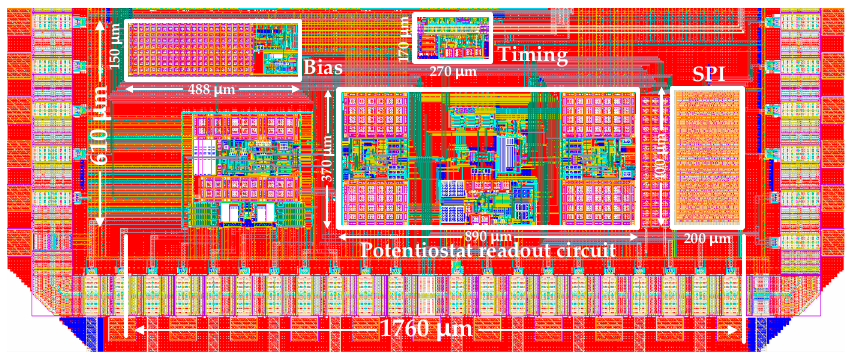
Figure 9. Layout of proposed readout circuit.